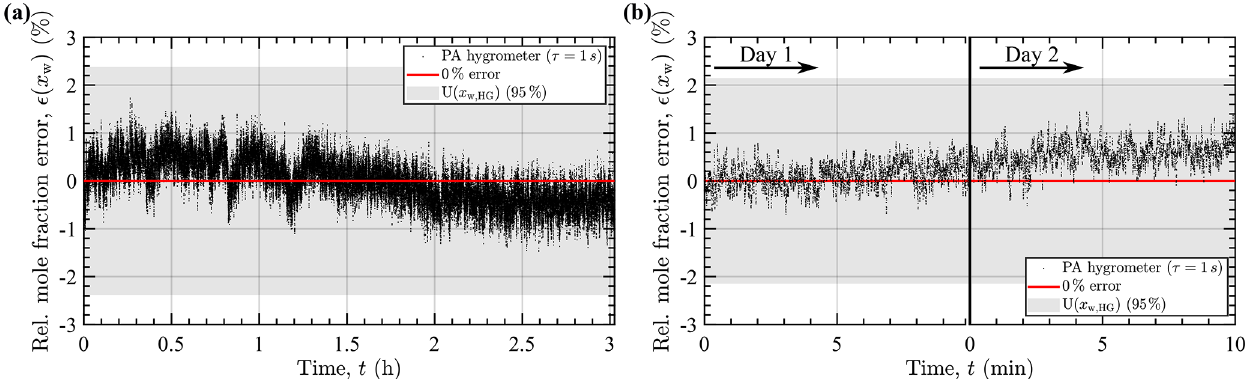
Figure 8. Hygrometer measurement stability. (a) Relative deviation of the measured water vapor mole fraction from the reference concentra- tion of 9620 ( 80 ) ppm supplied by the calibration unit over time. (b) Relative deviation on two consecutive days, measured at a mole fraction of 18800 ( 160 ) ppm and calculated using the calibration of day 1 in both measurements. The gray bands mark the relative uncertainty of the water vapor mole fraction provided by the humidity generator ( a ± 2 . 4%, b ± 2 . 2%, both 95% coverage). The lock-in integration time used for all measurements was